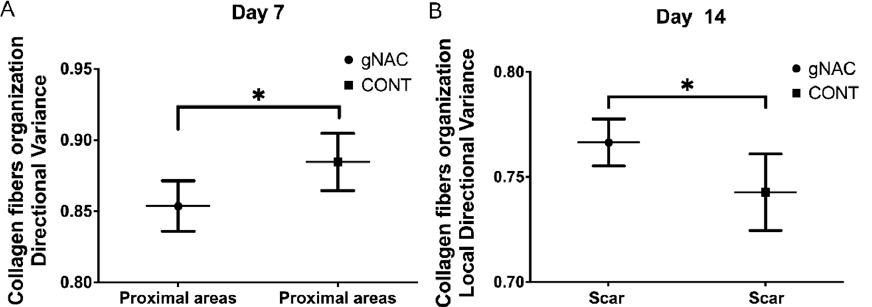
Figure 6. Graph represents directional variance distribution of collagen fibers in proximal scar areas ( A ) and scars ( B ) on the 7th and 14th days, respectively, in gNAC vs. CONT groups. Values expressed as mean ± SD, * p < 0.05.